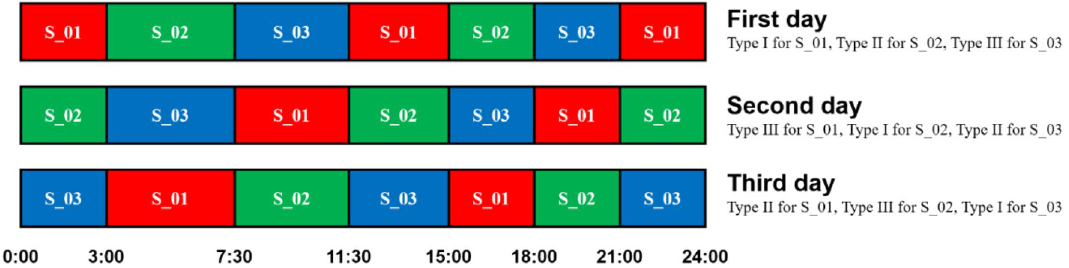
Figure 5. Shift work schedule of three subjects in a three-day cycle. The red, green, and blue areas represent the working segments of subjects S_01, S_02, and S_03, respectively. Each subject work 7 segments every three days, consisted of one Type I day, one Type II day, and one Type III day. (The figure was generated by PowerPoint 2019, URL: https:// www. micro softs tore. com. cn/ softw are/